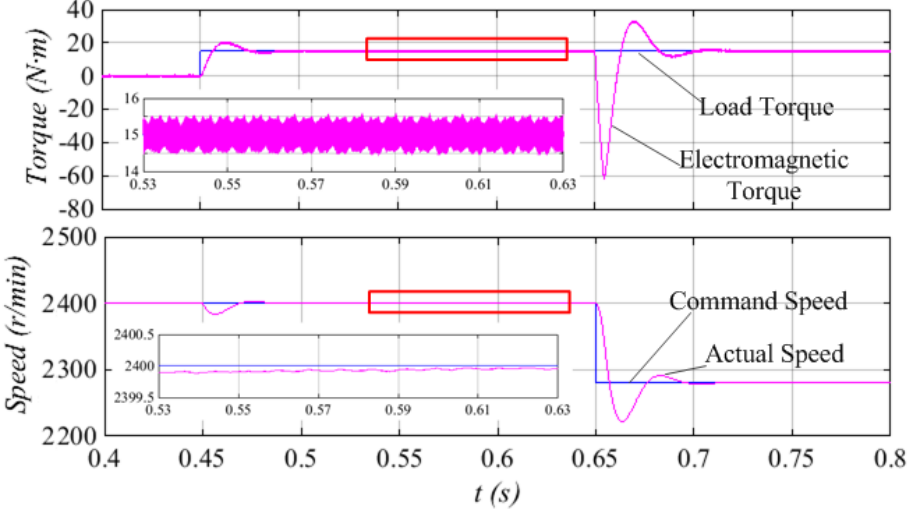
Figure 12. Simulation results of electromagnetic torque T e and rotor speed n for the DZICMV.